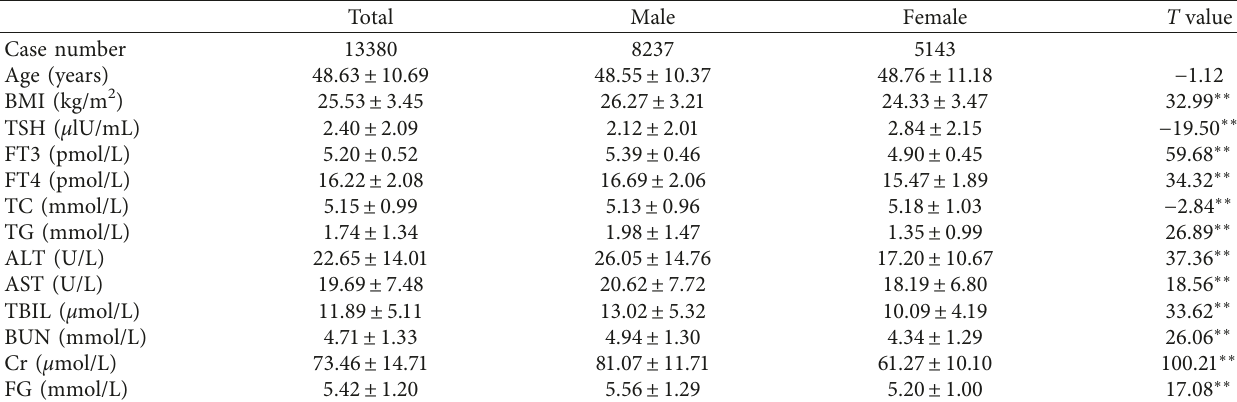
Table 1: Participant characteristics based on different